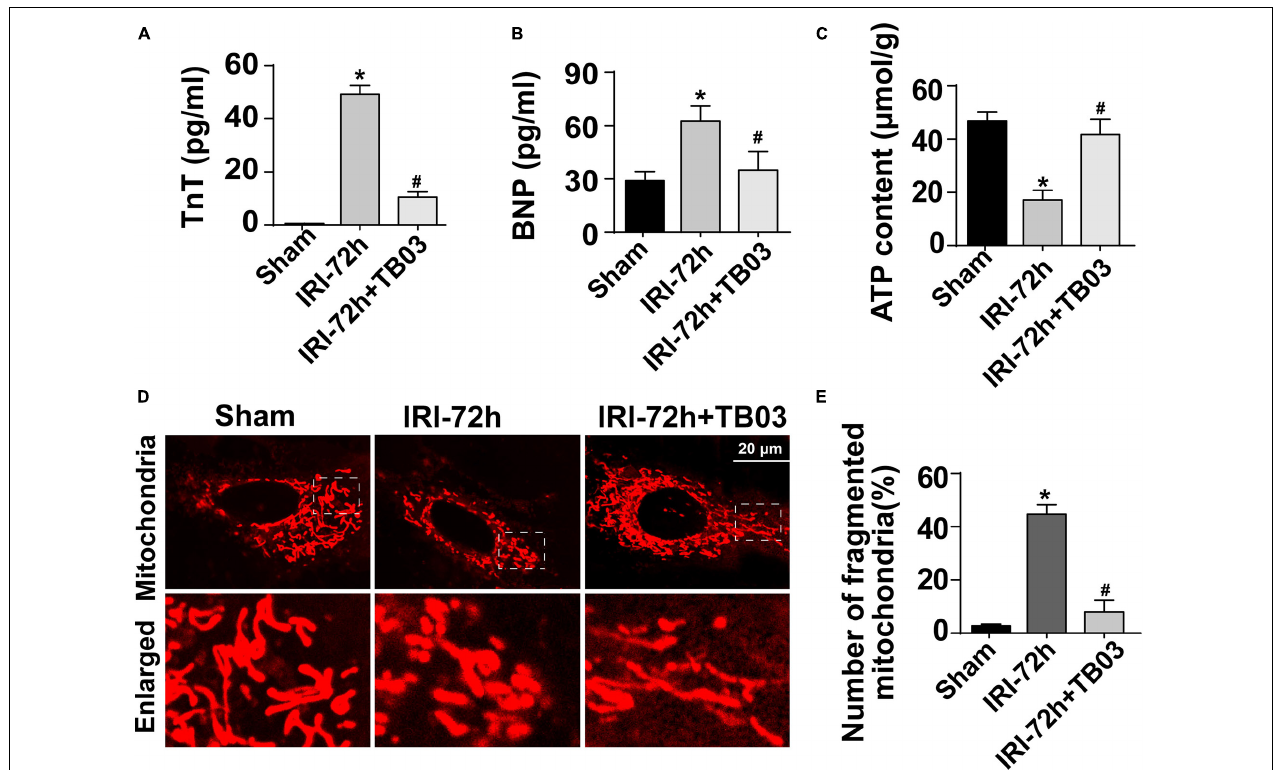
FIGURE 4 | Exogenous administration of Grb2 inhibitor improves cardiac performance, cardiomyocyte metabolism, and mitochondrial function following acute kidney injury (AKI) surgery. (A,B) A specific antagonist of Grb2 (TB03) was injected into mice 30 min before renal ischemia–reperfusion surgery. Then, levels of TnT and serum BNP from mice after AKI were determined through ELISA. (C) Levels of ATP production were measured through Enhanced ATP Assay Kit. (D,E) Cardiomyocytes were isolated from mice after AKI. Then, immunofluorescence was used to observe mitochondrial fragmentation. The number of fragmented mitochondria was observed in response to TB03 treatment. * p < 0.05 vs. sham group, # p < 0.05 vs. IRI-72h group.